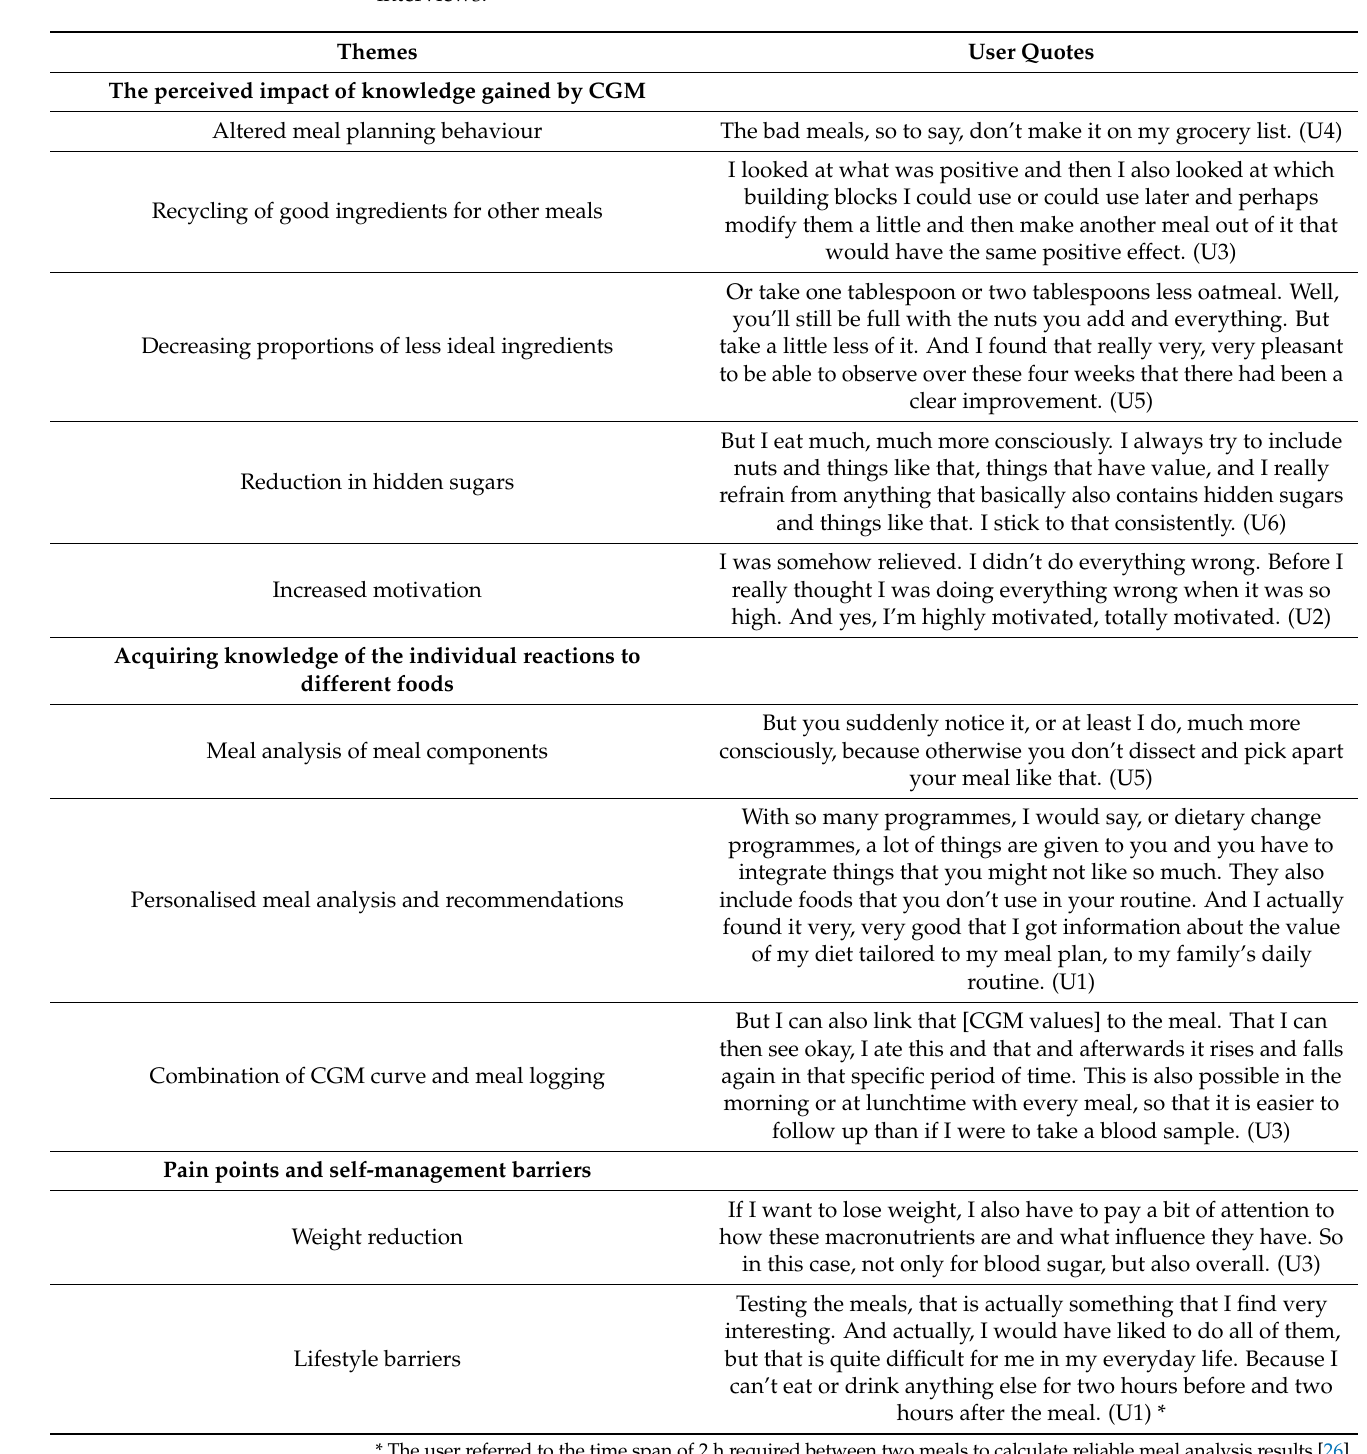
Table 4. Coding frame and example codes as a result of the thematic analysis conducted on 6 user